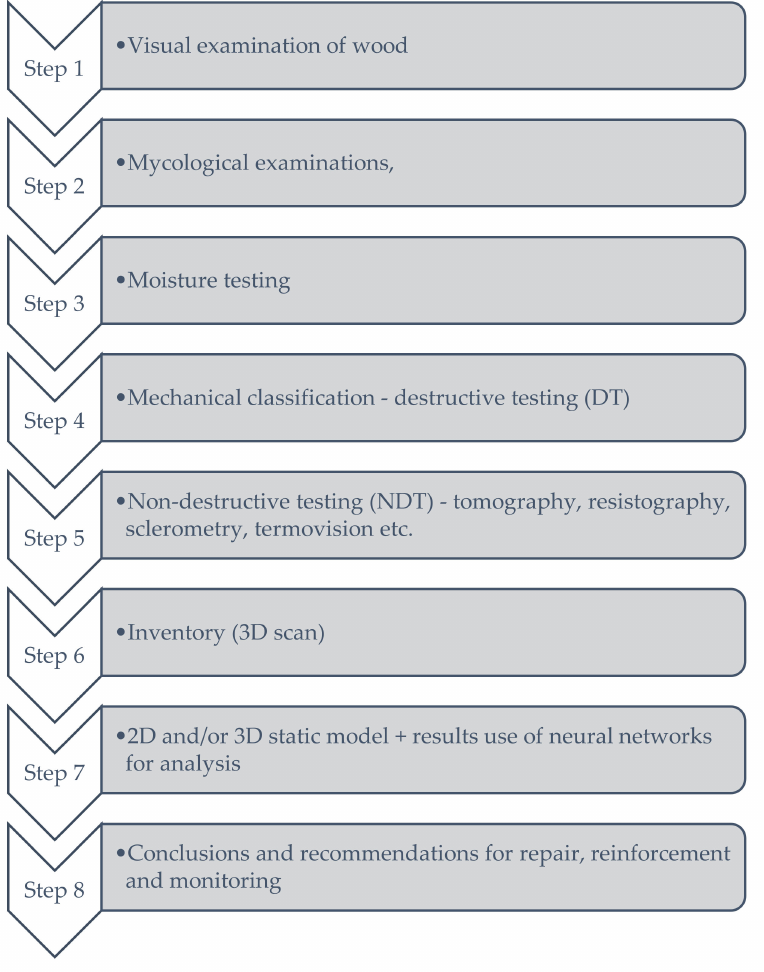
Figure 9. A pathway for the analysis of timber